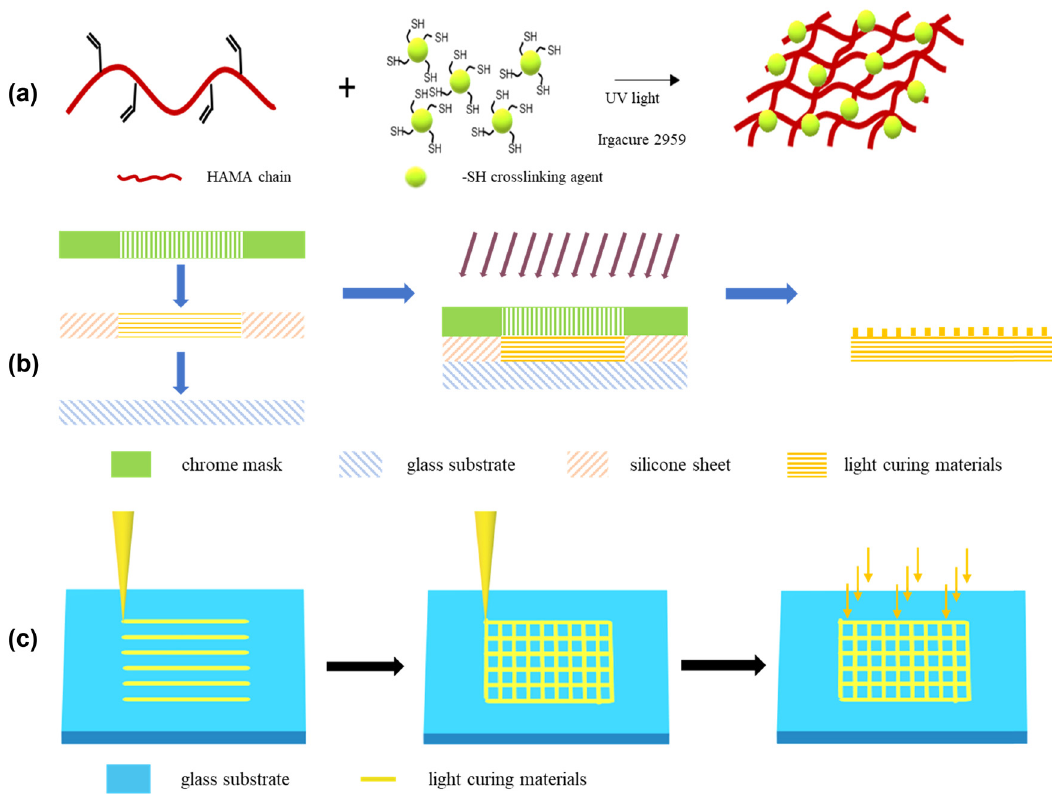
Figure 2: ( a ) Schematic of reaction for HAMA - gel; ( b ) surface microstructure fabricated by the photolithography method; and ( c ) well - zigzag microstructure printed by the light - cured inkjet printing